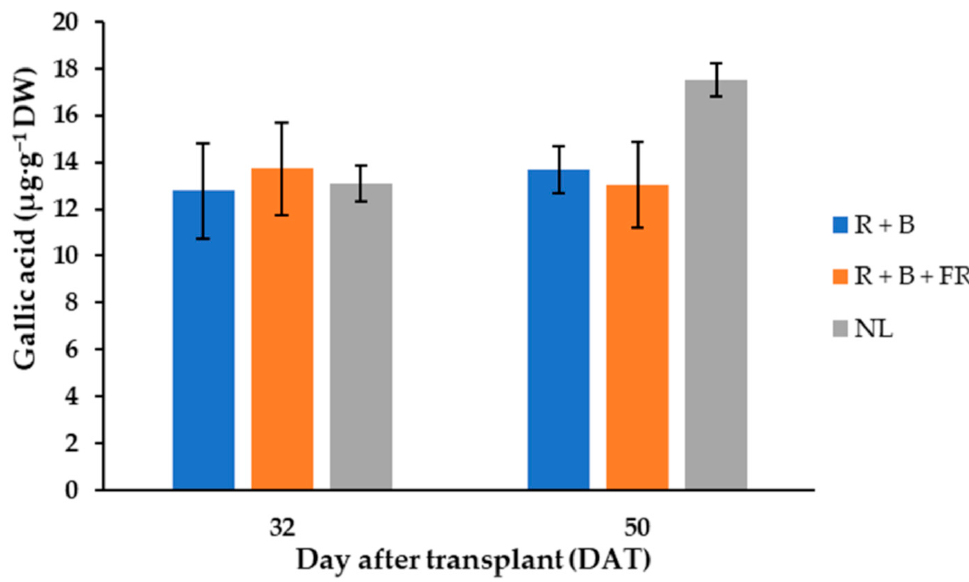
Figure 3. Gallic acid content of “Carosello leccese” ( Cucumis melo L.) fruits grown under solar light (NL, no supplementary lighting) and two light spectra (see Figure 1). Values are the average of three replications. Vertical bars represent mean values ± standard error. R + B represents supplementary light with red + blue spectra; R + B + FR represents supplementary light with red + blue + far red spectra; NL represents solar light (control) treatment.